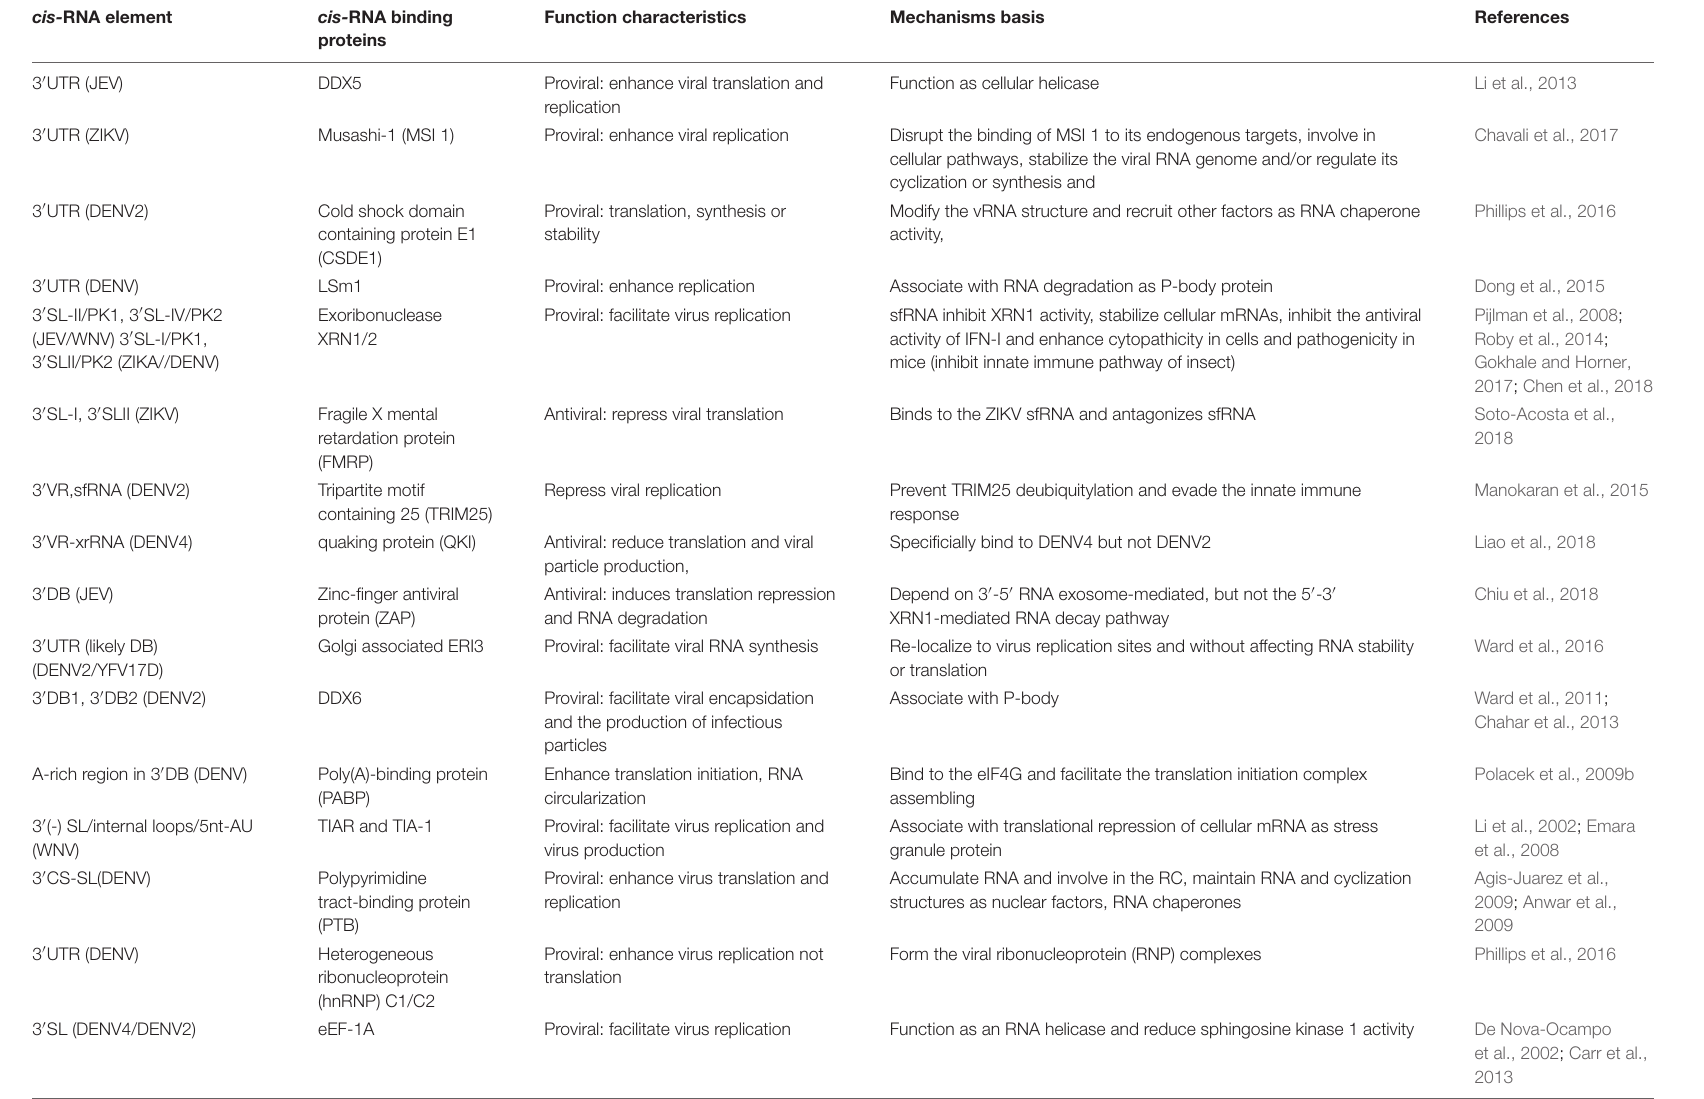
TABLE 3 | Terminal 3 (cid:48) cis- acting RNAs and the binding proteins involved in MBFV life cycle. cis- RNA